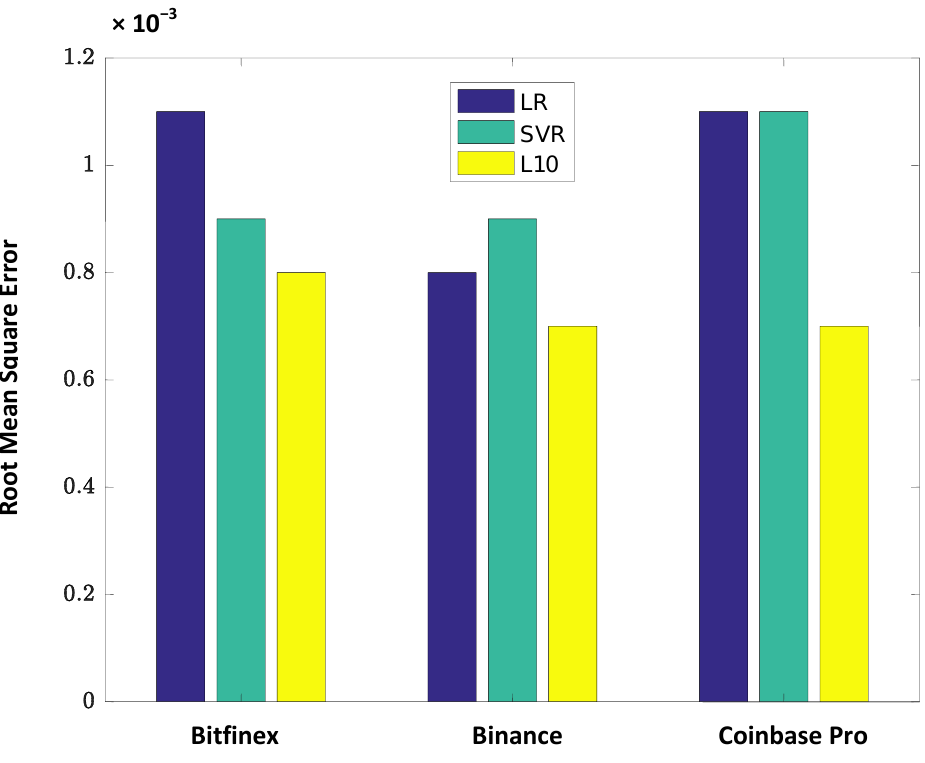
Figure 13. RMSE comparison for the three datasets.